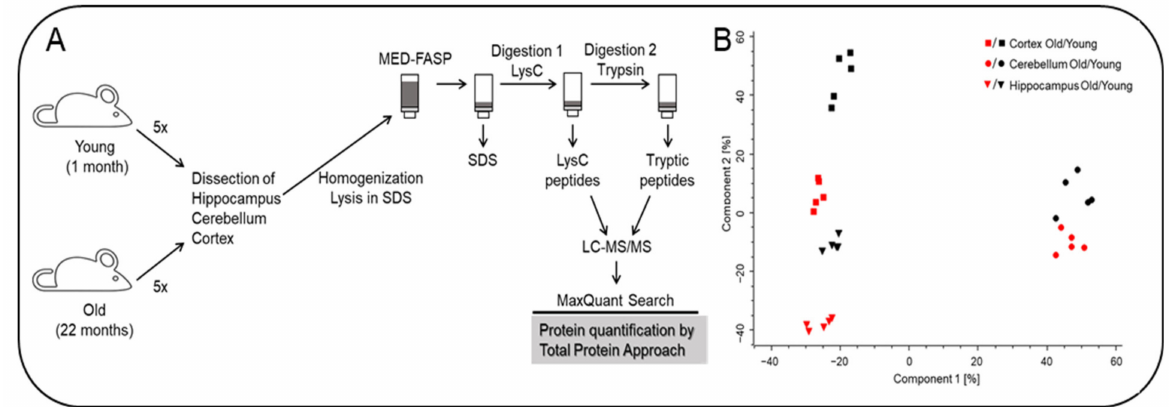
Figure 1. Proteomic analysis of the hippocampus, cortex and cerebellum from young and old mice. ( A ) Proteomic workflow. Brain tissue was isolated from 5 animals per group. The tissue lysates were processed by the MED-FASP procedure with two steps of enzymatic digestion. Peptides were analyzed by LC-MS/MS. The spectra were searched using MaxQuant software. Proteins were quantified by means of Total Protein Approach. ( B ) Principal component analysis of the proteomic